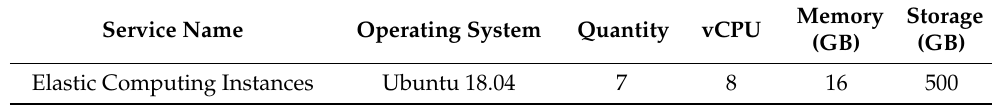
Table 10. Cloud resource list for Pattern